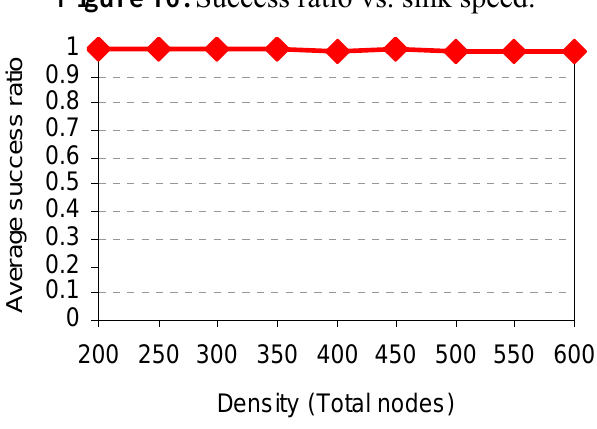
Figure 16. Success ratio vs. sink